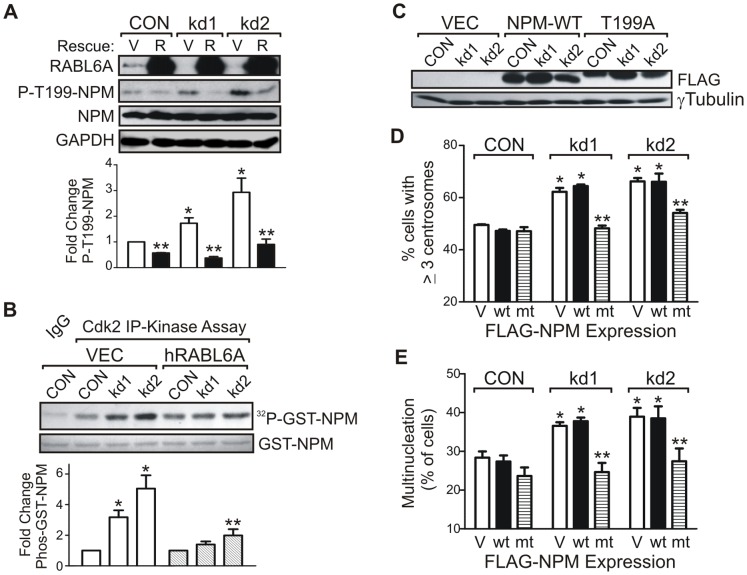
RABL6A loss leads to centrosome amplification and multinucleation via upregulation of NPM-T199 phosphorylation.(A) p53−/− MEFs expressing CON, kd1 or kd2 shRNAs were infected with vector (V) or human RABL6A (R) rescue viruses and levels of total NPM, phosphorylated NPM at T199 (P-T199-NPM), RABL6A, and GAPDH (loading control) measured by immunoblotting. The fold change in P-T199-NPM levels (normalized to total NPM) was quantified from 3 separate studies (below). *, p<0.01 compared to CON. **, p<0.05 for (R) versus (V) samples. (B) Autoradiograph of GST-NPM phosphorylation (32P-GST-NPM) from the indicated cell lysates following immune complex kinase assay using IgG control or Cdk2 antibodies. Graph shows the fold change in phosphorylated GST-NPM upon RABL6A loss (kd1 and kd2) or human RABL6A rescue (hRABL6A) as quantified from three experiments. * and **, p<0.01 and p<0.05 for samples relative to CON. (C, D and E) CON, kd1 and kd2 p53−/− MEFs infected with vector (VEC, V), FLAG-tagged wild-type NPM (wt) or FLAG-tagged T199A NPM mutant (mt) were assayed by western blotting (C) and immunofluorescent staining for centrosome amplification (D) and multinucleation (E). Quantified data from three separate experiments show rescue of the RABL6A loss phenotype by T199A but not WT NPM expression (*, p<0.01 compared to CON; **, p<0.01 relative to V or wt samples). Statistical significance of the data for panels A, B, D and E was determined using two-way ANOVA analyses.